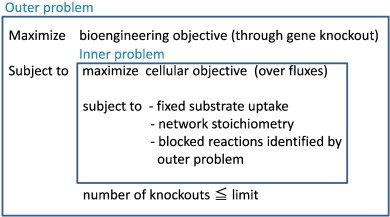
A framework of the bilevel programming [2].